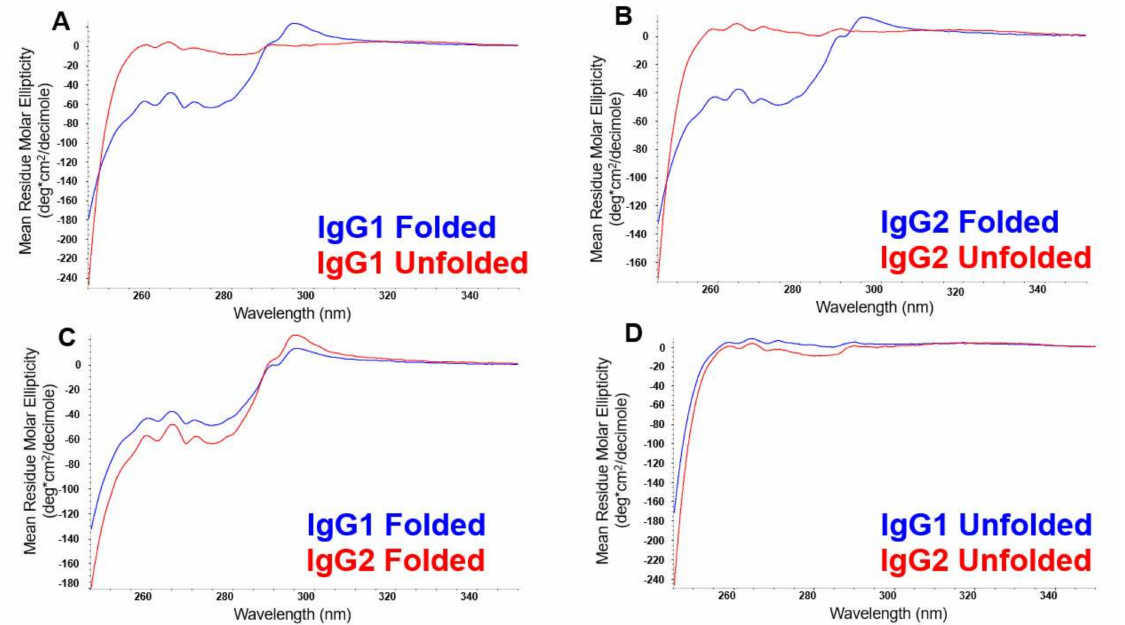
Figure 1. NUV-CD spectra of the folded and unfolded samples of IgG1 ( A ) and IgG2 ( B ). Comparison of the spectra from the folded states of the IgG1 and IgG2 molecules in ( C ), and the unfolded states for these two molecules in ( D ). The FLD spectra of the folded and unfolded states of IgG1 and IgG2 are shown in Figure 2. The emission wavelengths of the internal fluorophores: tryptophan, phenylala- nine, and tyrosine, are sensitive to the polarity of their environments. Higher polarity environments, particularly water from the solvent, cause the wavelengths of emission to lengthen (i.e., red shift). Therefore, unfolded proteins with more solvent-exposed